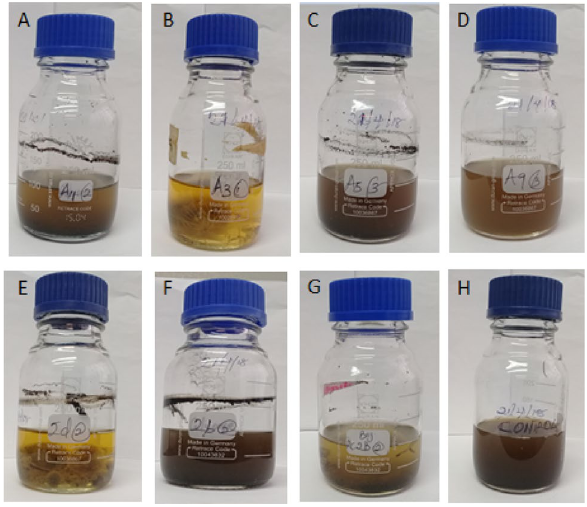
Fig. 3 Biosolubilization activity of seven most active strains. A RIZ4.2 ( Axonopus compressus ). B RIZ3.1 ( Emilia coccinea ). C RIZ5.3 ( Synedrella nodiflora ). D RIZ9.3 from ( Ageratum conyzoides ). E RCZ2D.2 ( Axonopus compressus ). F RCZ2B.2 ( Emilia coccinea ). G RCZ2B.2B ( Emilia coccinea ). H Control